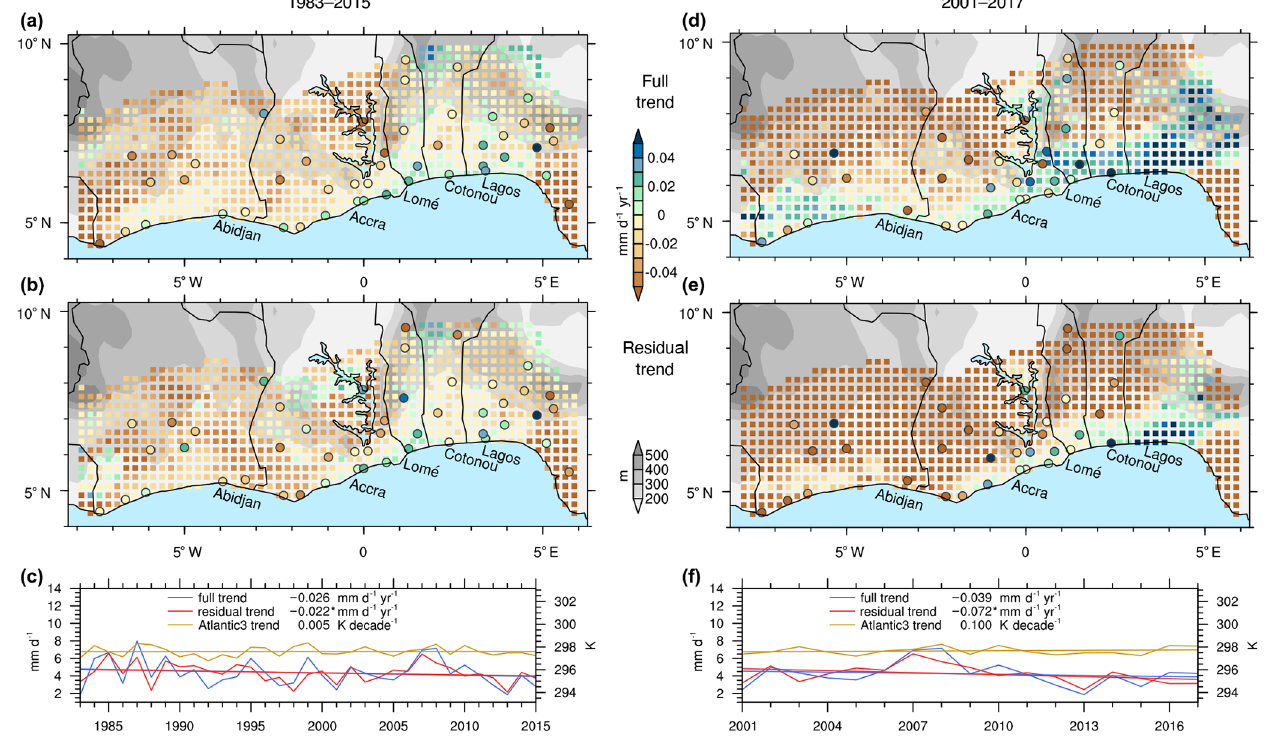
Figure 5. Rainfall trends during the little dry season. (a–c) Trends in rainfall from 1983–2015 for CHIRPS data (coloured pixels) and station data (coloured circles). Panels (d) , (e) , and (f) are the same as (a) , (b) , and (c) but for recent trends from 2001–2017. Shown are full (a, d) and residual (b, e) trends. Note the overall good agreement between CHIRPS and station data. Topography is shown in grey shadings. “Residual” in this context means that a statistical model was used to remove the influence of other known climatic factors on rainfall (for details, see Sect. 2.4). Time series (c, f) of full (blue) and residual (red) CHIRPS rainfall, spatially averaged over the entire region, and the Atlantic 3 climate index (gold) are shown together with their trends over the respective time span. A * in (c) and (f) marks statistically significant trends on the α = 20%